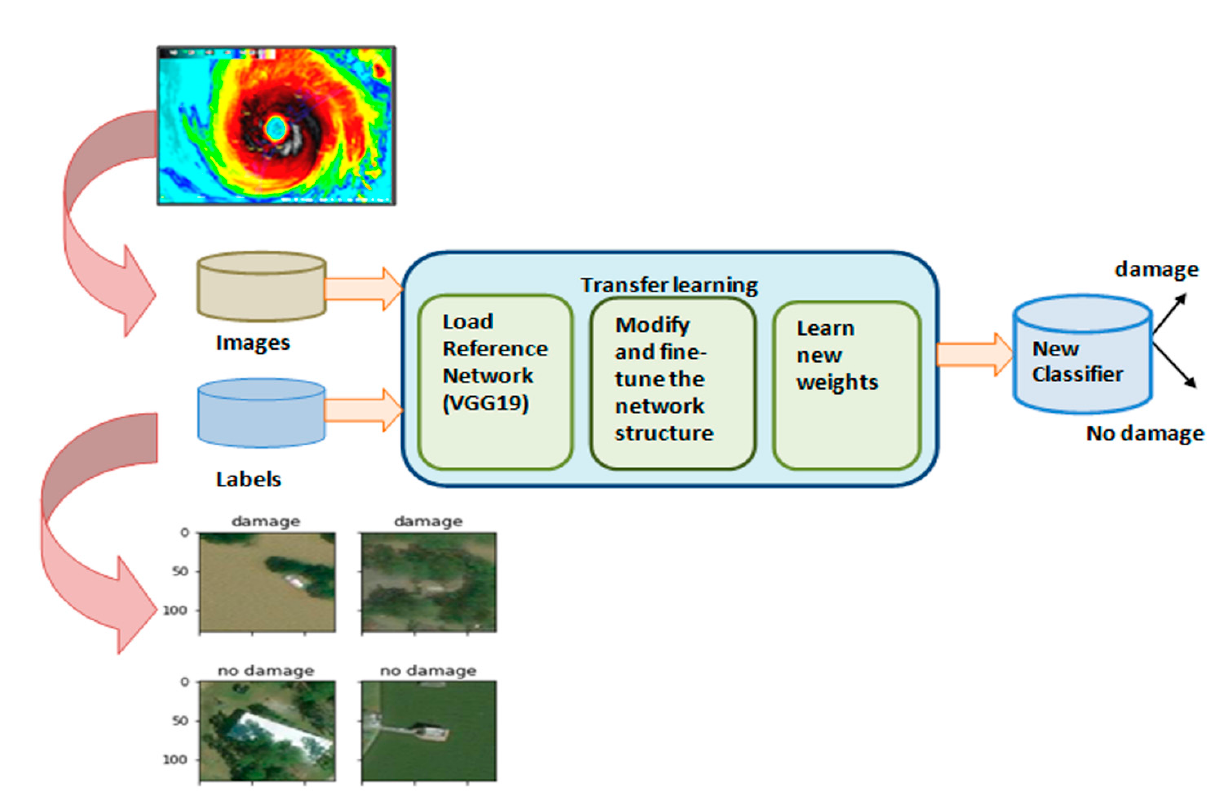
Figure 9. Architecture diagram for hurricane damage classification.